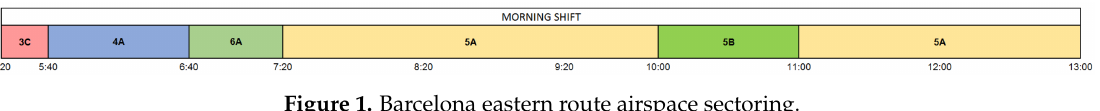
Figure 1. Barcelona eastern route airspace